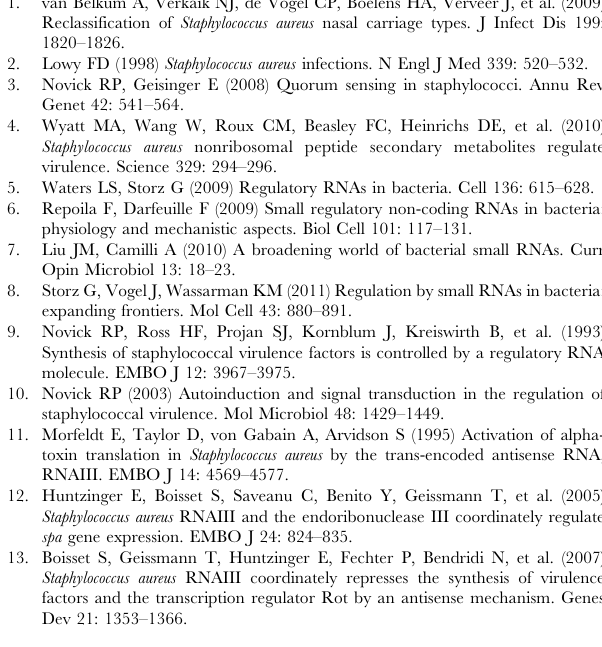
Figure S1 Kinetics of sRNAs expression in vitro in laboratory strains. Strains RN6390 (sigmaB defective, plain line) and HG001 (sigmaB restored, dotted line) were grown in BH media until the mid- (OD 550 = 0.5) (open triangle) or late- exponential (OD 550 =6) (plain triangle) growth phases. Total RNA was extracted, and the sRNA transcripts were quantified using RT-PCR normalized to gyr B mRNA expression. The results represent the mean of 2 replicate experiments. (TIF) Figure S2 Kinetics of RNAIII expression in vitro according to three different calibrators. Nine clinical S. aureus strains, selected as representatives of the diversity of expression levels observed using the calibrator gyr B, were grown in BH media until the mid (OD 550 = 0.5) (open shape) and late- exponential (OD 550 =6) (plain shape) growth phases. Total RNA was extracted, and the RNAIII transcript levels were quantified using RT-PCR normalized to gyr B mRNA, 4.5S RNA and rnp B sRNA expression. (TIF) Table S1 primers used for reverse transcription and qPCR on